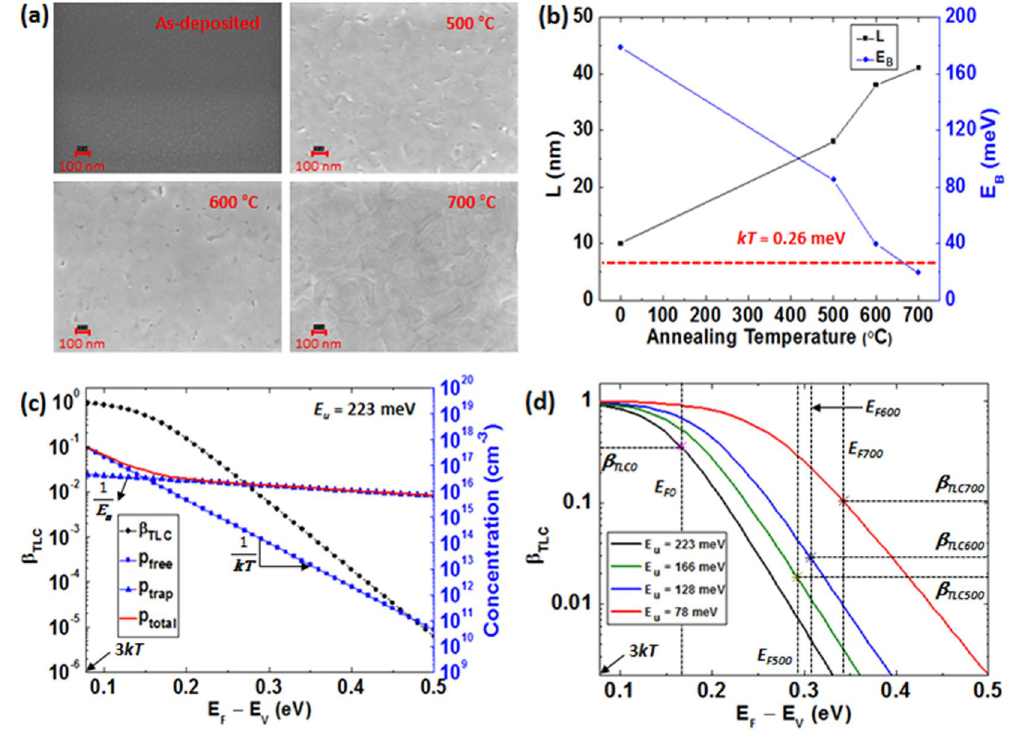
Figure 4. ( a ) SEM images of the surface of as-deposited and annealed Cu 2 O films, ( b ) the estimated grain size ( L ) and energy barrier height at grain boundaries ( E B ) as a function of annealing temperature, ( c ) calculated p free , p trap , p total and β TLC when E u = 223 meV and (d) β TLC when E u = 223 meV (as-deposited), E u = 166 meV (500 °C), E u = 128 meV (600 °C) and E u = 78 meV (700 °C) as a function of E F − E V . In ( b ), the red dot line shows the thermal energy at room temperature. In ( c ), p free was calculated using Equation (12) given by Boltzmann’s approximation which is valid for E F − E V ≥ 3 kT . In ( d ), E F 0 , E F 500 , E F 600 and E F 700 denote the Fermi energy of the as-deposited film and 500, 600 and 700 °C-annealed films, and the corresponding β TLC values are β TLC 0 = 0.36, = 0.018, β = 0.029 and β = 0.1, β TLC 500 TLC 600 TLC 700